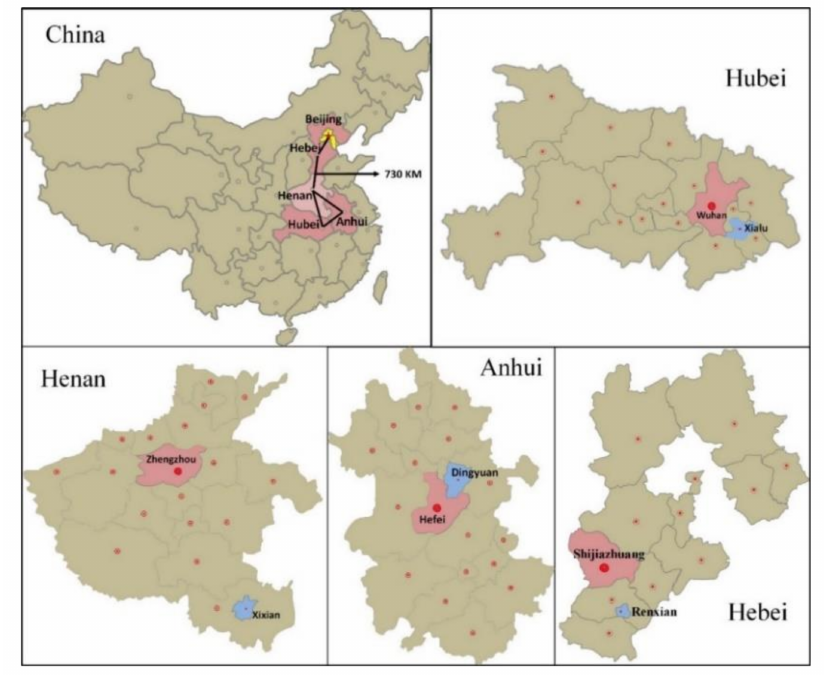
Figure 1. Sampling